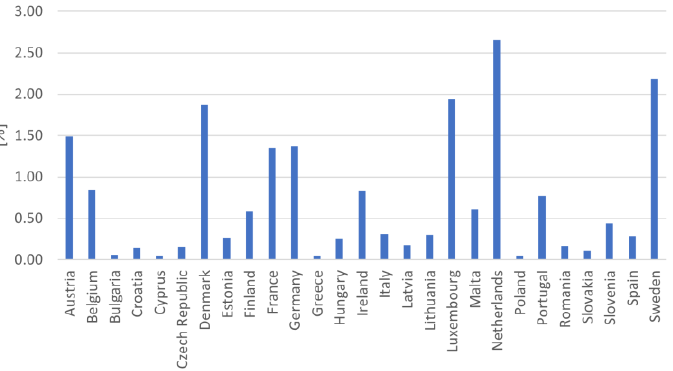
Figure 3. Total number of electric vehicle passenger vehicles (M1) and vans (N1) in 2021 at the European level (source [25]).